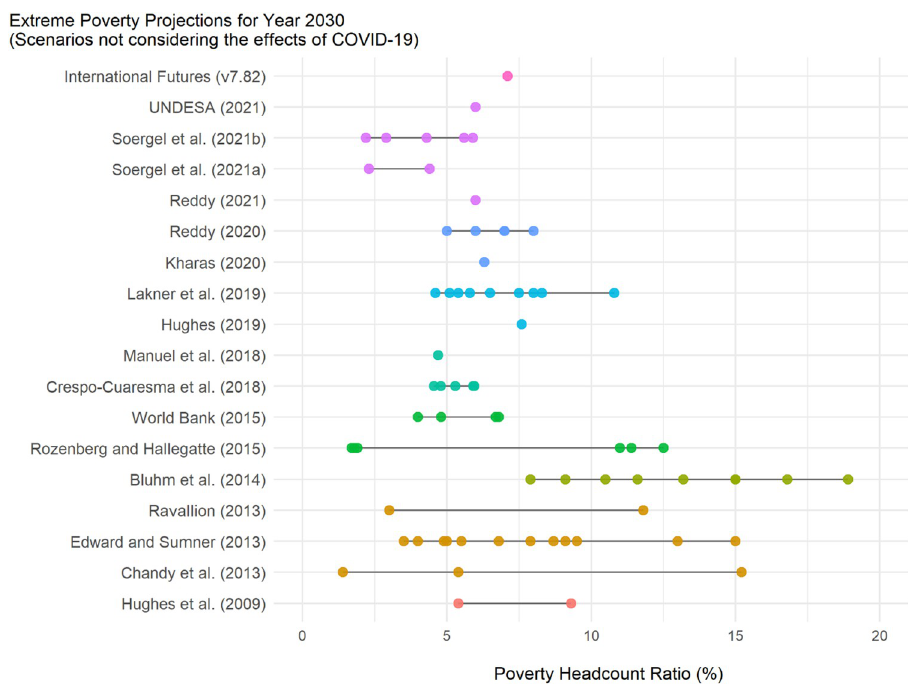
Fig 2. Previous projections of extreme poverty levels summary that do not account for COVID-19. Each point represents a scenario outcome value–point color reflects year published. Studies published in or before 2015 expressed using extreme poverty line of $1.25/day (USD2005). Hughes et al. [4] figures expressed using poverty line of $1.00/day (USD2005). Studies after 2015 use extreme poverty line of $1.90/day (USD2011). Different income thresholds are comparable because they are expressed using different real dollar thresholds that attempt to capture similar levels of PPP across time.